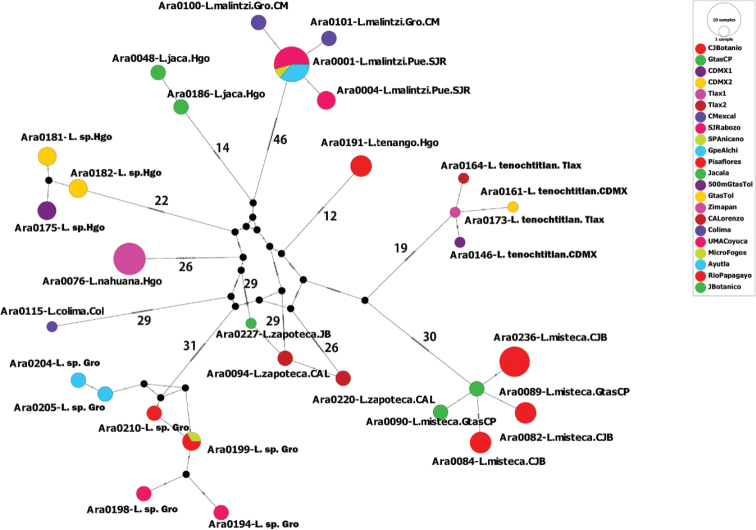
Haplotype network from the CO1 data obtained with TCS using PopArt. Each circle represents the haplotypes found in ten species of Loxosceles from Mexico. Numbers on branches indicate the number of mutations between haplotypes.